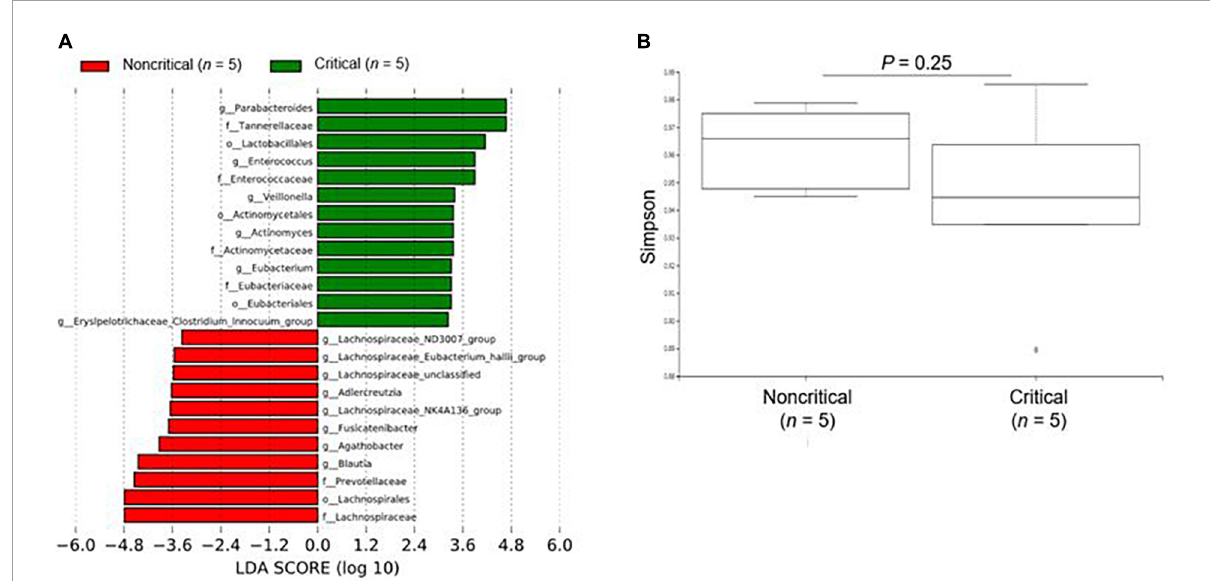
FIGURE2 Microbiome analysis of fecal contents from COVID-19 patients. (A) The enriched gut microbiota constituents were identified by linear discriminant analysis (LDA) effect size (LEfSe). The histogram shows taxa with LDA scores with (log 10) values > 3 and P < 0.05. g_ means genus, f_ means family, and o_ means order. (B) The α -diversity represented by the Simpson index. The vertical axis shows the Simpson index. Box-and-whisker plots show the median, 25th and 75th percentiles, with whiskers extending to the minimum and maximum values. Data were analyzed using Mann–Whitney U test. Statistical significance was accepted as P <